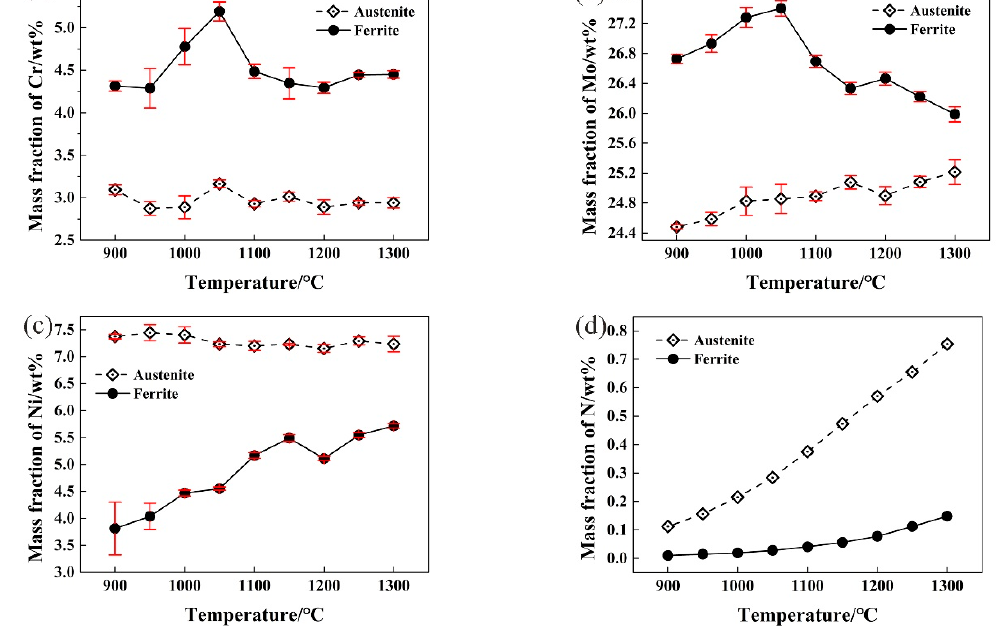
Figure 4. Chemical composition of austenite and ferrite phase in the UNS S32750 steel varies with solution treatment temperature. ( a ) Cr content; ( b ) Mo content; ( c ) Ni content; and ( d ) N content (error bars represent standard deviation).